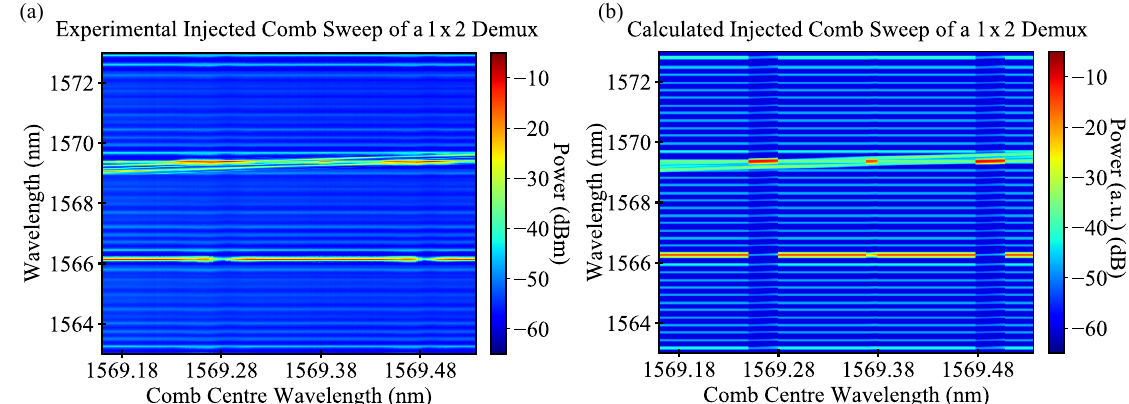
Figure 7. ( a ) Experimental and ( b ) calculated injected comb sweeps of an optical demultiplexer,